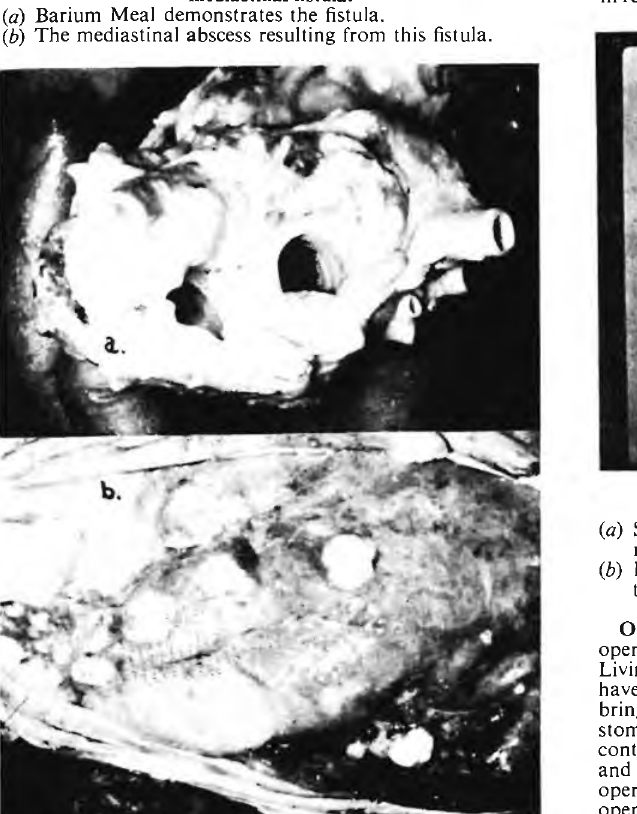
Fig. 4. Mediastinal invasion by the aquamous carcinoma. (a) The trachea, aorta and great vessels of the neck com­ pletely encased in the growth. (b) The heart studded with metastatic deposits of squamous carcinoma originating in the oesophagus.